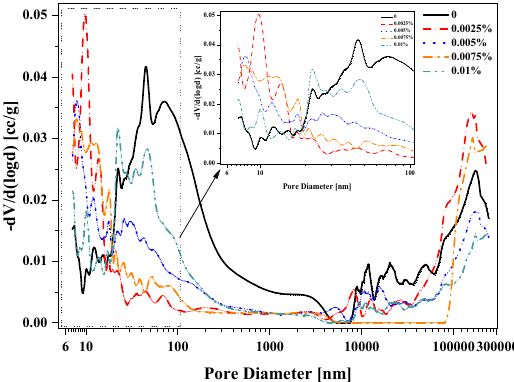
Figure 4. Influence of defoamer on the pore size distribution of grouts.